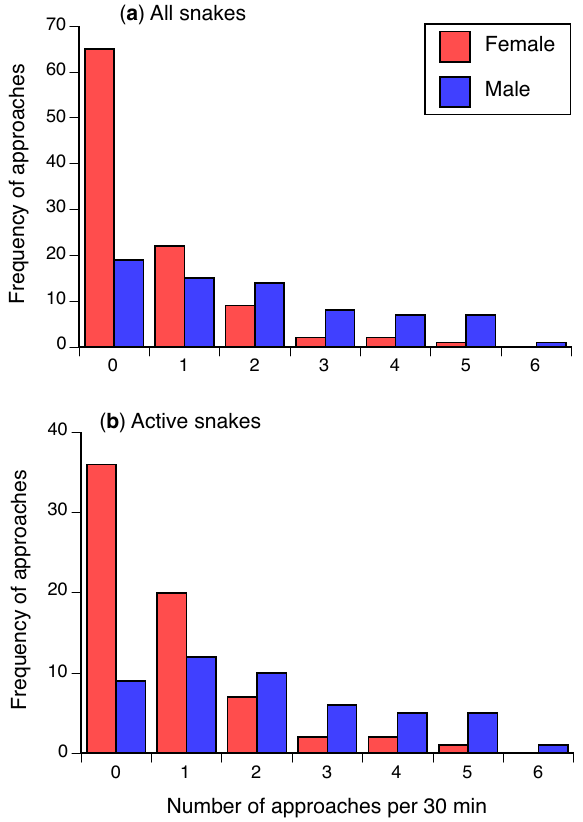
Figure 1. Approaches to divers by Olive sea snakes ( Aipysurus laevis ) as a function of snake sex. The graph shows the total frequency of approaches per 30-min observation period recorded over the duration of the study, divided based on whether all snakes are included ( a ) or only snakes that were active during the focal observation period ( b ).